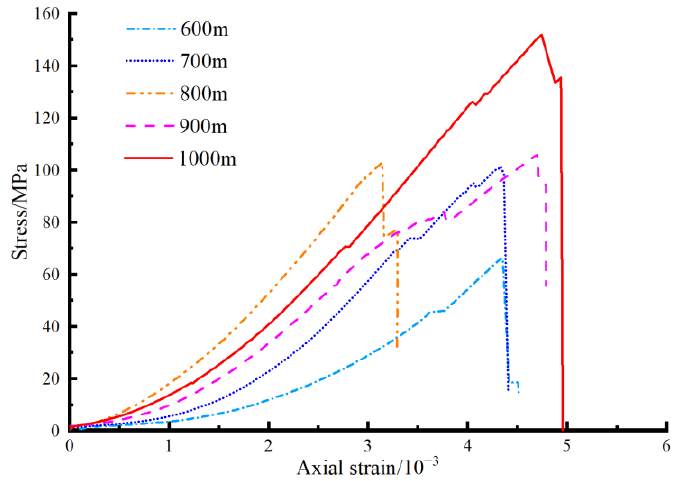
Figure 3. Stress – strain curves of the limestone with different burial depths. Figure 3. Stress–strain curves of the limestone with different burial Table 1. Physical and mechanical parameters.